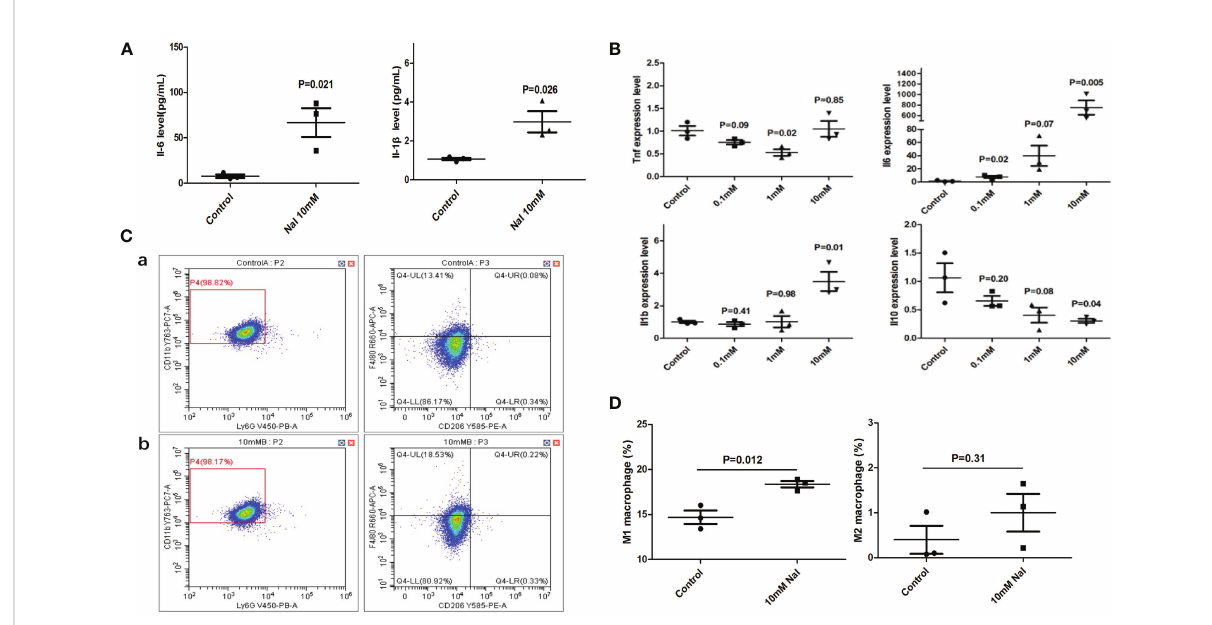
FIGURE 2 High iodine stimulation of RAW264.7. (A) ELISA results of supernatants; (B) qRT-PCR results; (C) Flow cytometry of macrophage proportions. a: 0 mM of NaI control group; b:10 mM of NaI intervention group; (D) Statistics of macrophage proportions.